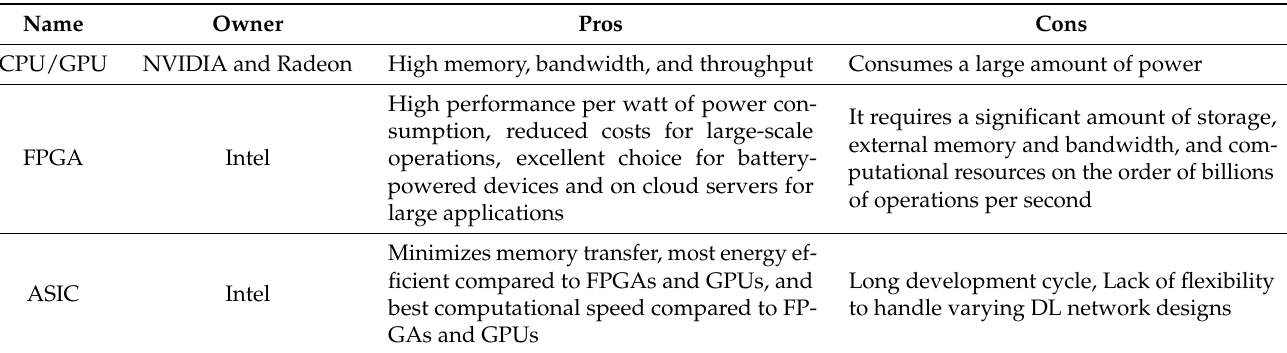
Table 3. Comparison of hardware accelerators for the implementation of federated learning in edge